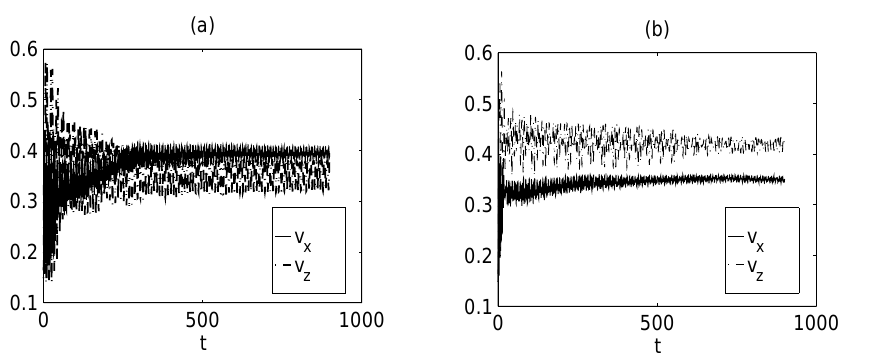
FIG. 23. rms velocities (in arbitrary units) for initially mismatched nonstationary distributions ( (cid:99) (cid:121) (cid:97) (cid:173) (cid:51)(cid:44) m (cid:120) (cid:173) m (cid:121) (cid:173) m (cid:122) (cid:173) (cid:49)(cid:46)(cid:53)(cid:44) h (cid:120) (cid:173) (cid:48)(cid:46)(cid:53)(cid:51)(cid:44) h (cid:122) (cid:173) (cid:48)(cid:46)(cid:51)(cid:57) ): (a) 6D uniform distribution and (b) 6D Gaussian